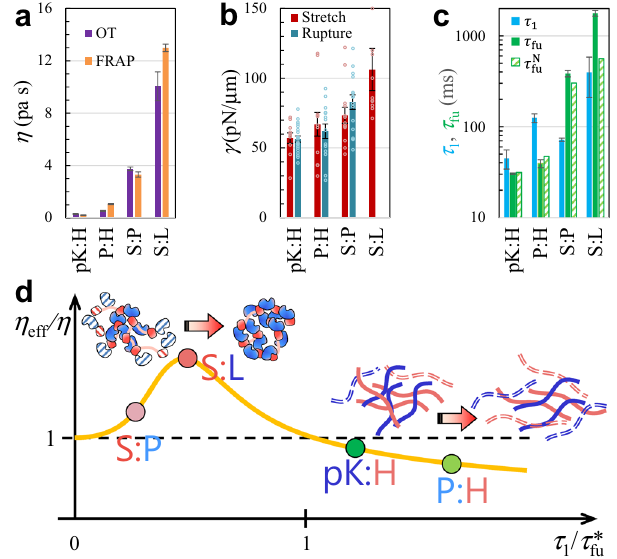
Fig. 4 Deviations of condensates from Newtonian fl uids. a Comparison of zero-shear viscosities from the present OT measurements and deduced from FRAP time constants in our previous study 26 . Results are presented as fi tted value ± standard error of the fi t. OT results were determined by fi tting the data in Fig. 3a to the Burgers model (Eq. 2a, b). FRAP results were converted from FRAP time constants (Eq. S15 in Supplementary Text); the latter in turn were determined by fi tting FRAP time traces (average of triplicate measurements) to an exponential function (Eq. S13 in Supplementary Text). For S:L droplets, the L concentration was 300 μ M in the OT measurements but 2000 μ M in FRAP; a somewhat higher η is thus expected in the FRAP experiment. For pK:H droplets, the equimolar component concentration was 100 μ M in the OT measurements but 50 μ M in FRAP. b Interfacial tensions from OT measurements, by either stretching ( N = 10 to 13) or rupturing ( N = 14 to 20) droplets. Dot plots display raw data from replicate measurements; bar graphs display mean ± standard error of the mean. The trap stiffnesses were 450 to 750 pN/ μ m in the stretching experiments and around 1600 pN/ μ m in the rupture experiments. Quanti fi cation of interfacial tension from rupture force involved an arbitrary scaling constant f (see Eq. 43 in Supplementary Information). For S:L droplets, the rupture force exceeded the trapping power of the instrument and hence only a lower bound of 100 pN/ μ m could be placed for γ . c Comparison of shear relaxation time ( τ 1 ; this study), ; data were determined here for pK:H and from measured fusion time ( τ fu ref. 26 for the other three types of droplets), and fusion time ( τ N ) predicted fu by the viscocapillary model. Results for τ were determined by fi tting the 1 data in Fig. 3a to the Burgers model (Eq. 2a, b), and are presented as fi tted value ± standard error of the fi t. Raw τ data ( N = 4 to 17 droplets with fu various sizes) were fi rst fi t to a linear function of droplet radius (Eq. 3); τ fu results in the bar graph represent fi tted slope± standard error of the fi t, both multiplied by a fi xed R = 3 μ m. d Shear thickening at τ 1 = τ (cid:4) < 1 and fu = τ (cid:4) shear thinning at τ > 1. The solid curve displays characteristic behaviors 1 fu of associative polymers. The illustration at the top shows a shear-induced strengthening of macromolecular networks; the illustration on the right shows the opposite = η = 0.83), due to shear-induced breakup of interchain ( η eff bridges (Fig. 4d, illustration on the right). We hope that our work will stimulate other experimental as well as theoretical studies to test these proposed explanations. The present work reveals the shear relaxation time, τ , as a key 1 determinant of condensate fusion dynamics. For our condensates, τ